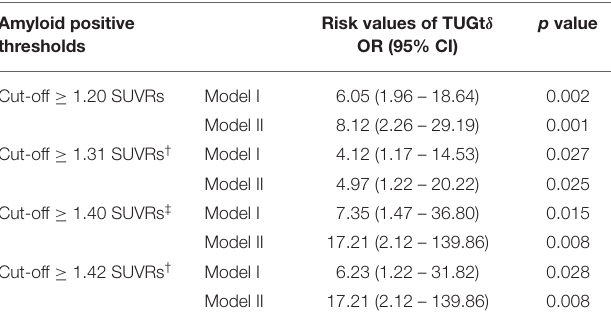
TABLE 2 | Binary logistic regression examining the association between TUGt cut-off points and different thresholds for amyloid positivity. Amyloid positive